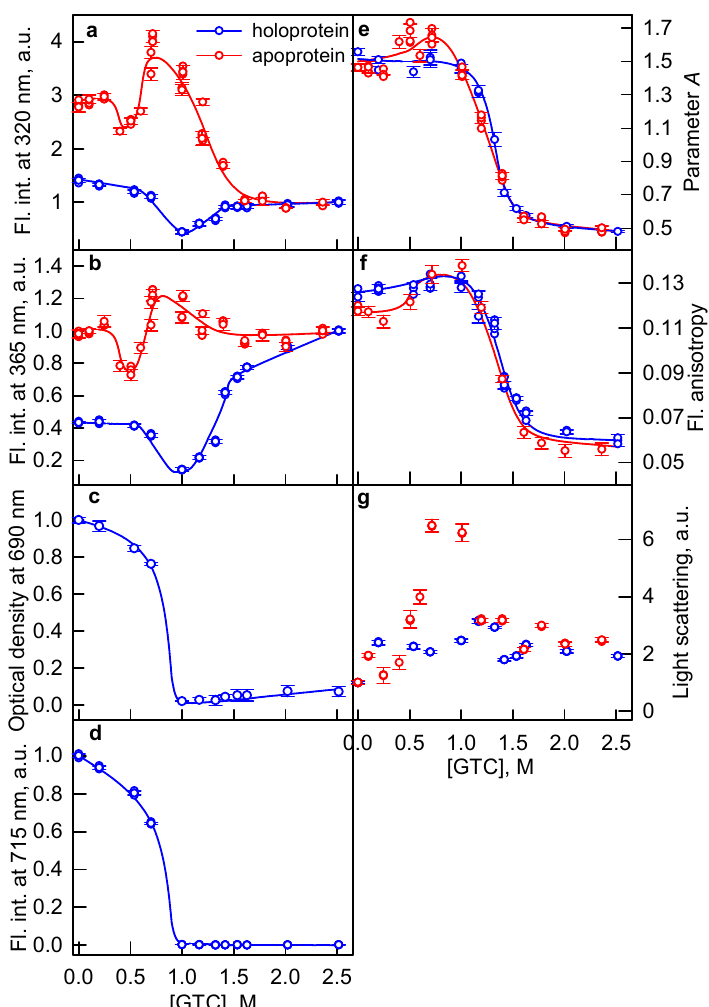
Figure 1. Unfolding of iRFP713 in the apoform and holoform induced by guanidine thiocyanate (GTC). ( a , b ) Changes in the tryptophan fluorescence intensity at an excitation wavelength of 295 nm and registration wavelengths of 320 and 365 nm. The values of fluorescence intensity I 320 and I 365 were normalized to unity at high denaturant concentration (2.5 M GTC). ( c ) Changes in optical density of the solution at a registration wavelength of 690 nm. ( d ) Changes in the chromophore fluorescence intensity at an excitation wavelength of 690 nm, corrected for the absorbance of the solution at the excitation wavelength (see Materials and Methods). ( e ) Changes in the parameter A = I 320 / I 365 at an excitation wavelength of 295 nm. ( f ) Changes in fluorescence anisotropy at an emission wavelength of 365 nm and excitation wavelength of 295 nm. ( g ) Changes in the light scattering. The values of the recorded characteristics for iRFP713 in the apoform and holoform are represented by red and blue circles, respectively. The measurements were performed after 24 h incubation of the native protein in the presence of GTC. Error bars are s.e.m., n = 3.